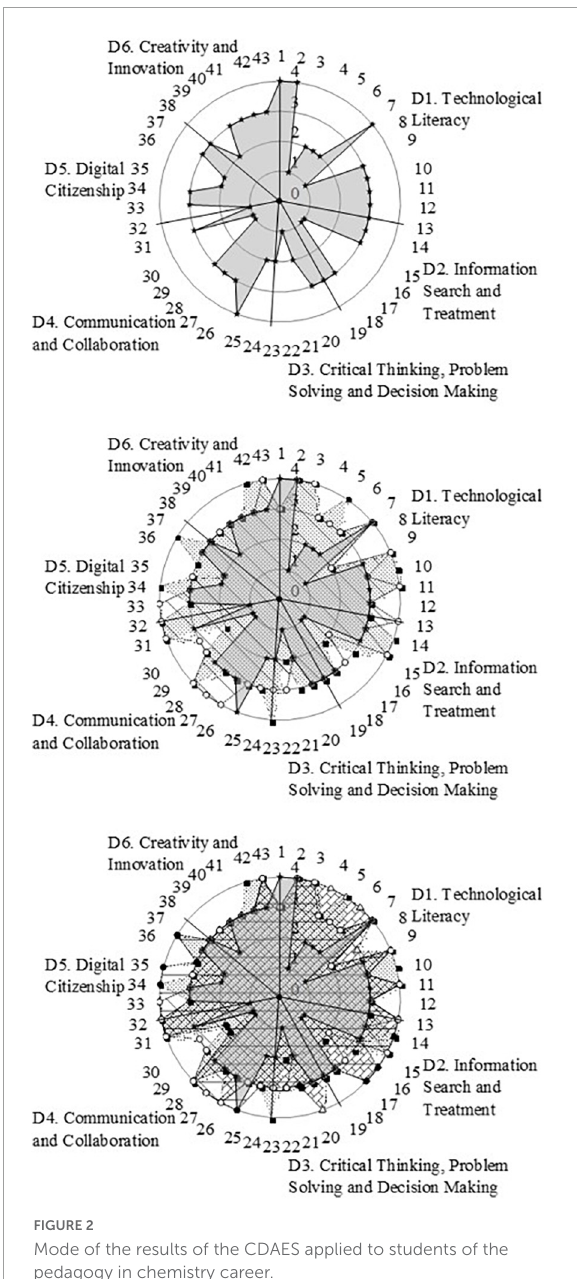
FIGURE2 Mode of the results of the CDAES applied to students of the pedagogy in chemistry career.